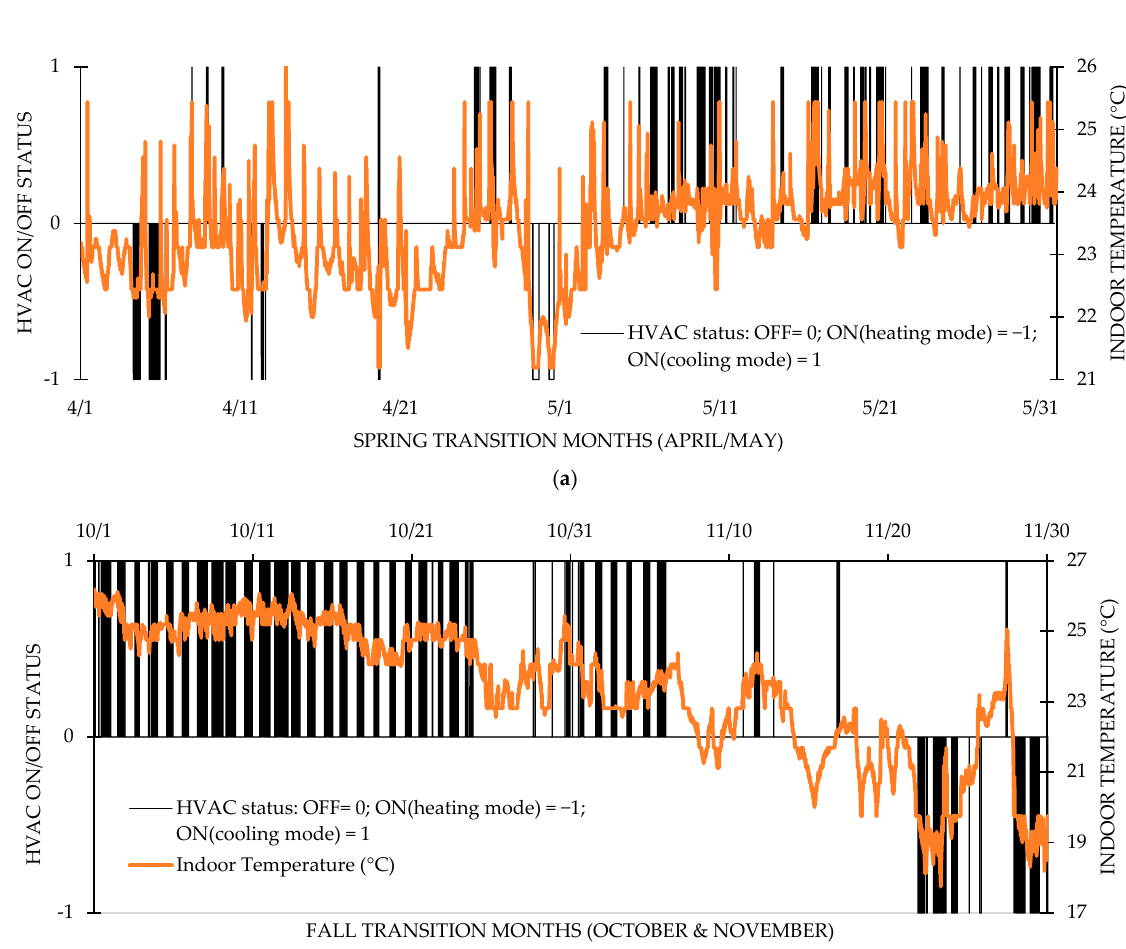
Figure 10. HVAC On/Off system working per period: ( a ) spring transition months (April and May); ( b ) fall transition months (October and November).